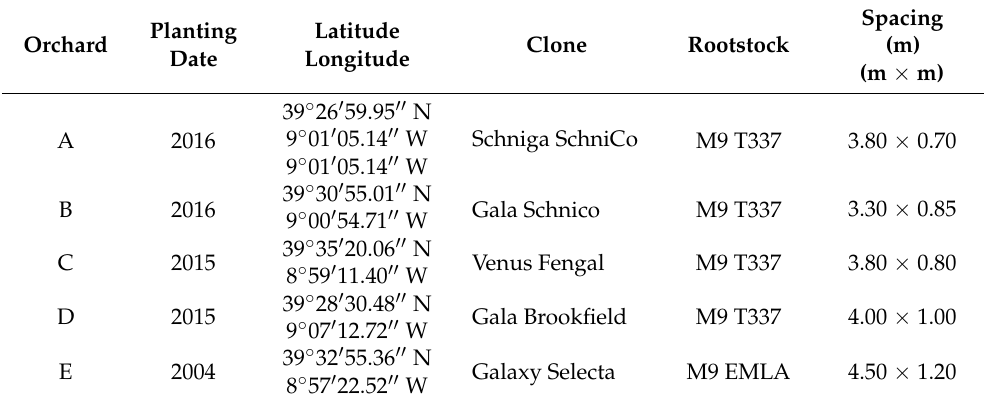
Table 2. Planting date, locations, Gala clone and rootstock and